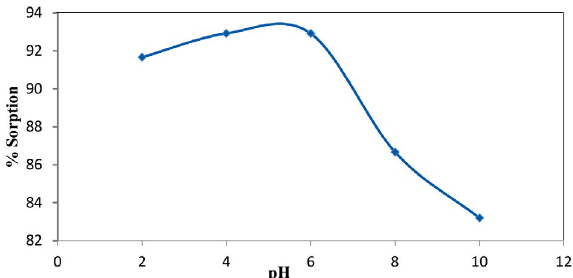
Figure 4. pH Effect for Cr(VI) sorption onto Isatin based Amberlite XAD-2 resin